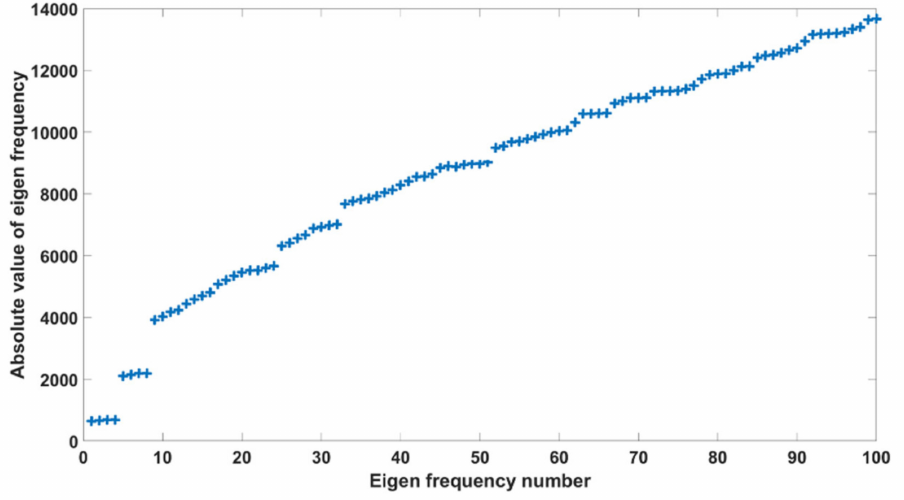
Figure 3. Eigenfrequency